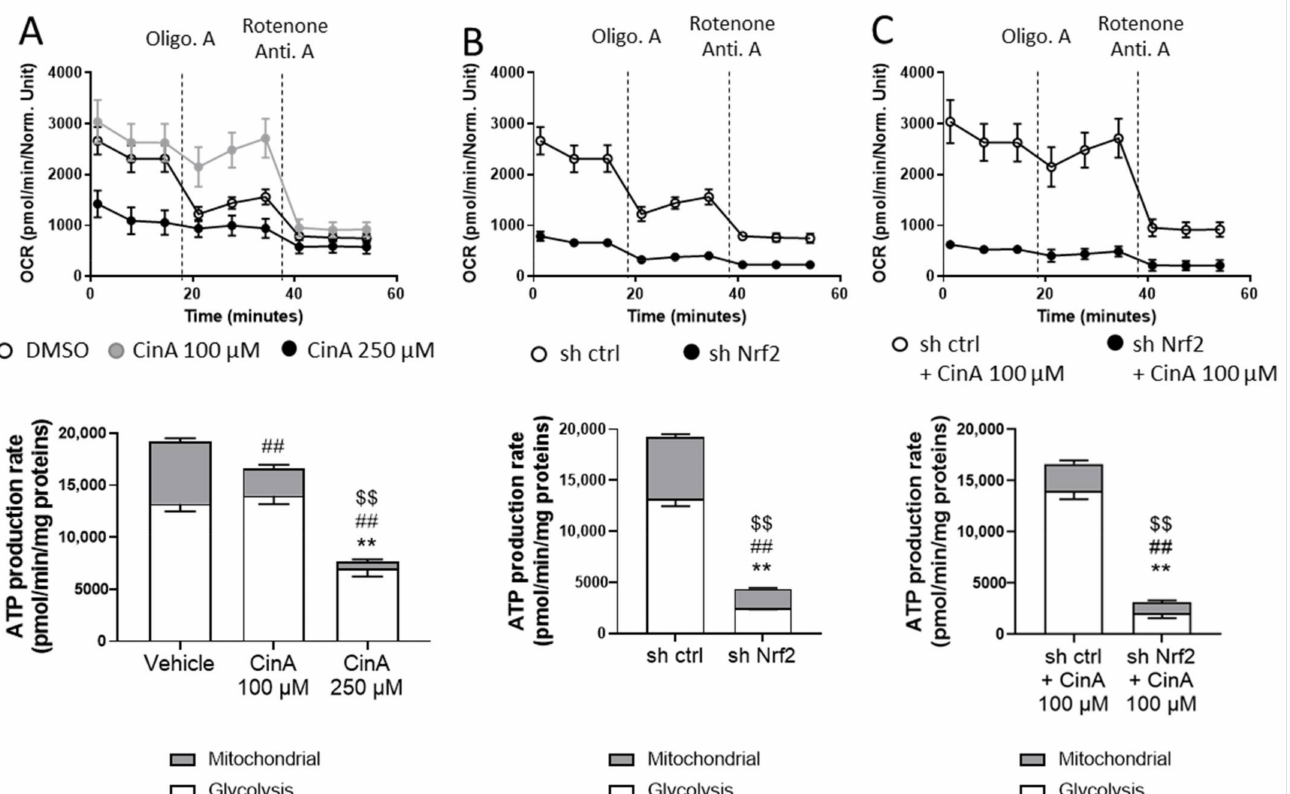
Figure 6. CinA and Nrf2 drive metabolic reprograming in KCs. KCs were invalidated for Nrf2 by transduction with lentiviral particles to express a short-hairpin RNA targeting Nrf2 (sh Nrf2) or a scrambled short-hairpin (sh ctrl) as the control cells, and the cells were exposed to 100 or 250 µ M of CinA for 1 h, followed by the seahorse analysis. ( A ) Oxygen consumption rate (OCR) and ATP production of sh ctrl cells exposed to CinA (100 or 250 µ M) and DMSO 0.1% as the control. ( B ) OCR and ATP production of unstimulated sh ctrl and sh Nrf2. ( C ) OCR and ATP production of sh ctrl and sh Nrf2 cells exposed to 100 µ M of CinA and DMSO 0.1% as the control. Data represent the results of 1 experiment with 8 replicates. ( A ) *, #, and $ represent statistical differences, between the vehicle and CinA-treated cells for glycolytic, mitochondrial, and total ATP production respectively. ( B , C ) *, #, and $ represent statistical differences between sh Sc and sh Nrf2 cells for glycolytic, mitochondrial, and total ATP production, respectively. **, ##, $$ p -value < 0.01 (Mann–Whitney